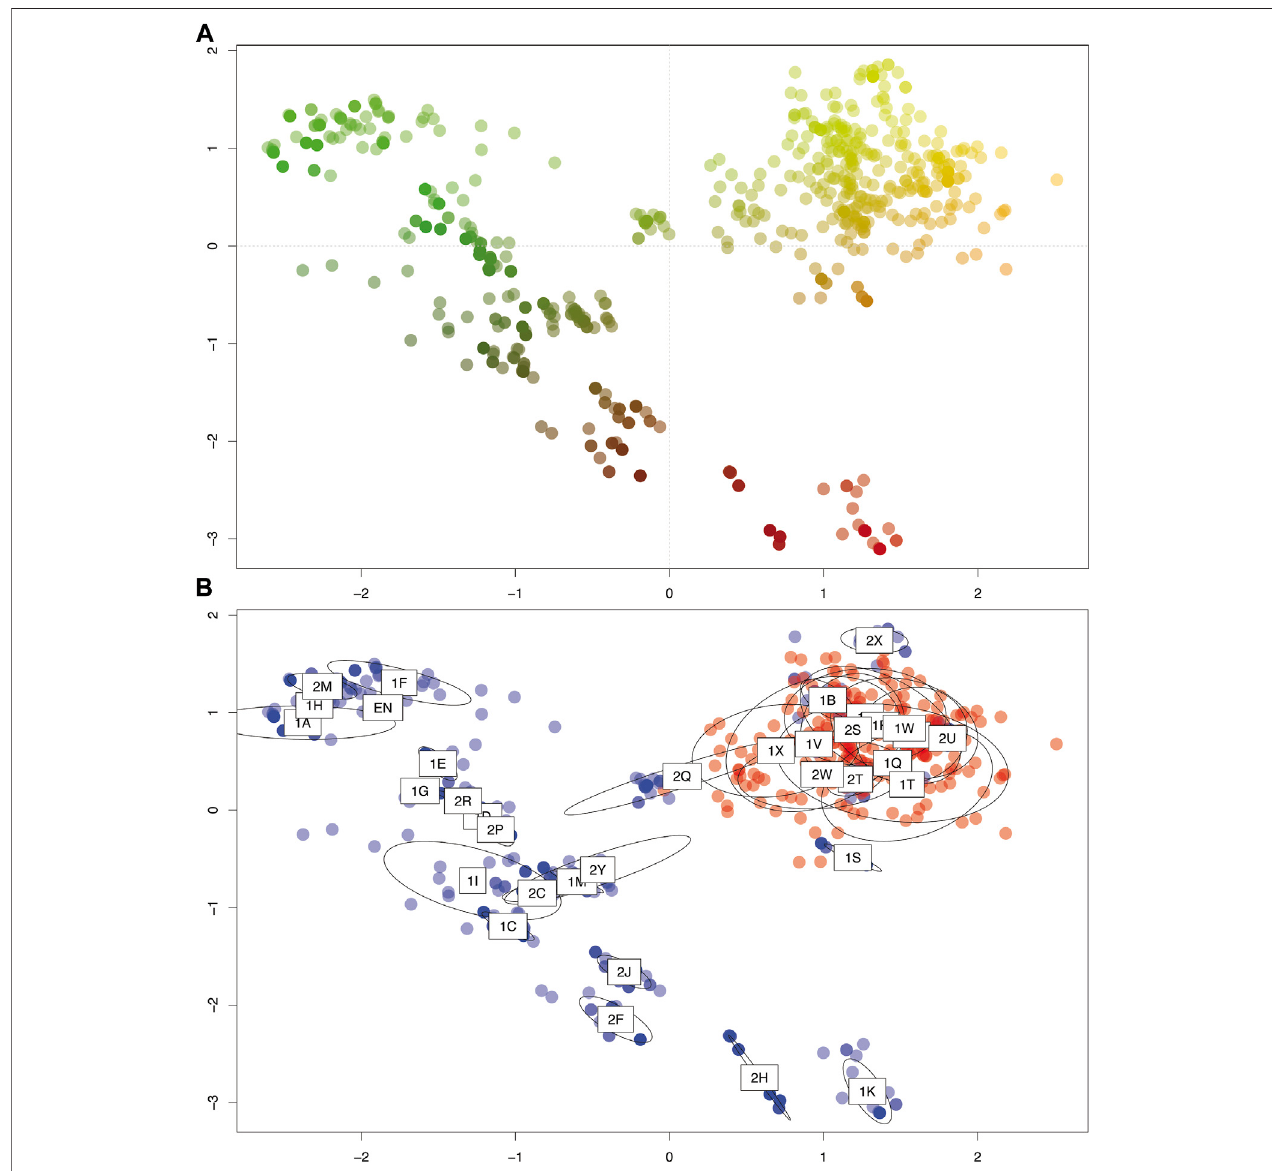
FIGURE4| Principlecoordinateanalysis(PCoA)ofthestudiedpopulationsof P.intermedium basedonpairwiseEuclidiandistanceusedintheDAPC(Discriminant Analysis of Principal Component) function of the ADEGENET R package. The fi rst two axes represent 37 and 21% of total variation, respectively. (A) Genetic similarity among all the individuals depicted by RGY color scheme (i.e., Red, Green, and Yellow distinct groups, and the shades of each color show how much related they are to eachpureRGYgroup). (B) Geneticvariationbetweencytotypes(red:diploids,blue:tetraploids)andpopulations(labelsindicatingpopulationcodesaremappedon the center of ellipses representing the 95% dispersion of individuals from each